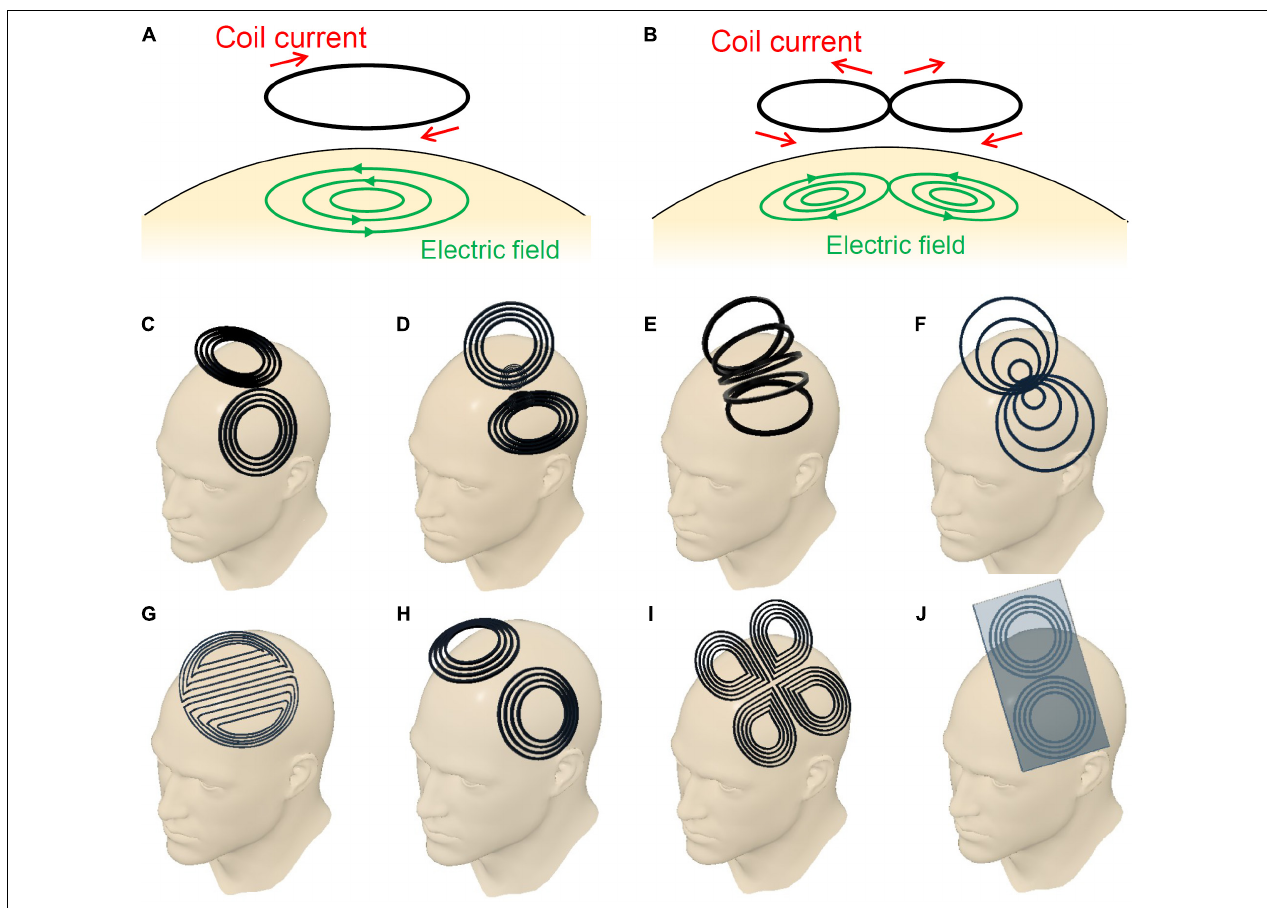
FIGURE 1 | (A) Circular coil, (B) planar figure-eight coil, (C) butterfly coil, (D) quadruple butterfly coil, (E) slinky coil, (F) eccentric figure-eight coil, (G) double-D coil, (H) H6-coil, (I) cloverleaf coil, and (J) figure-eight coil with iron